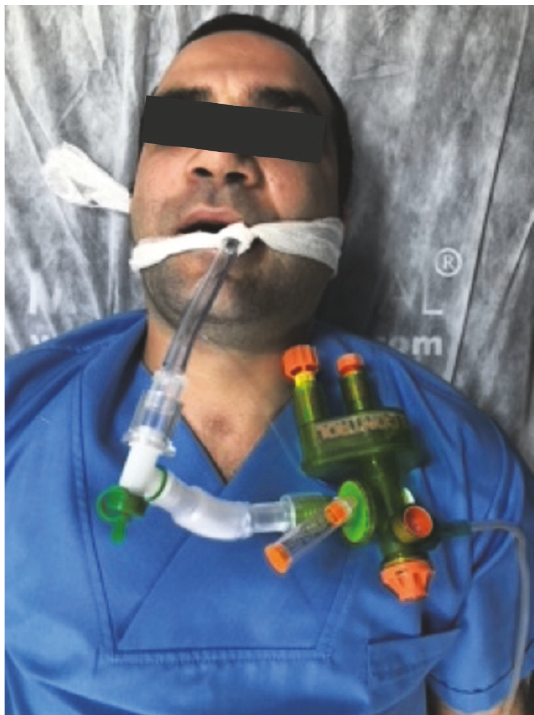
Figure 1: Demonstration of the